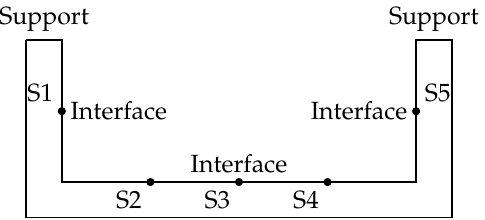
Figure 2. Boundaries of the finite element model with probe locations.